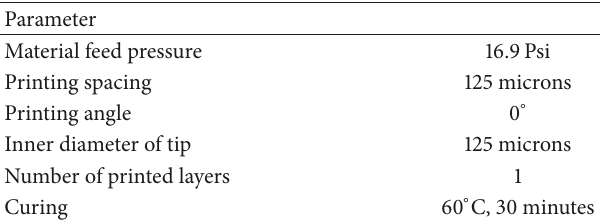
Table 1: The used 3D-printing and curing